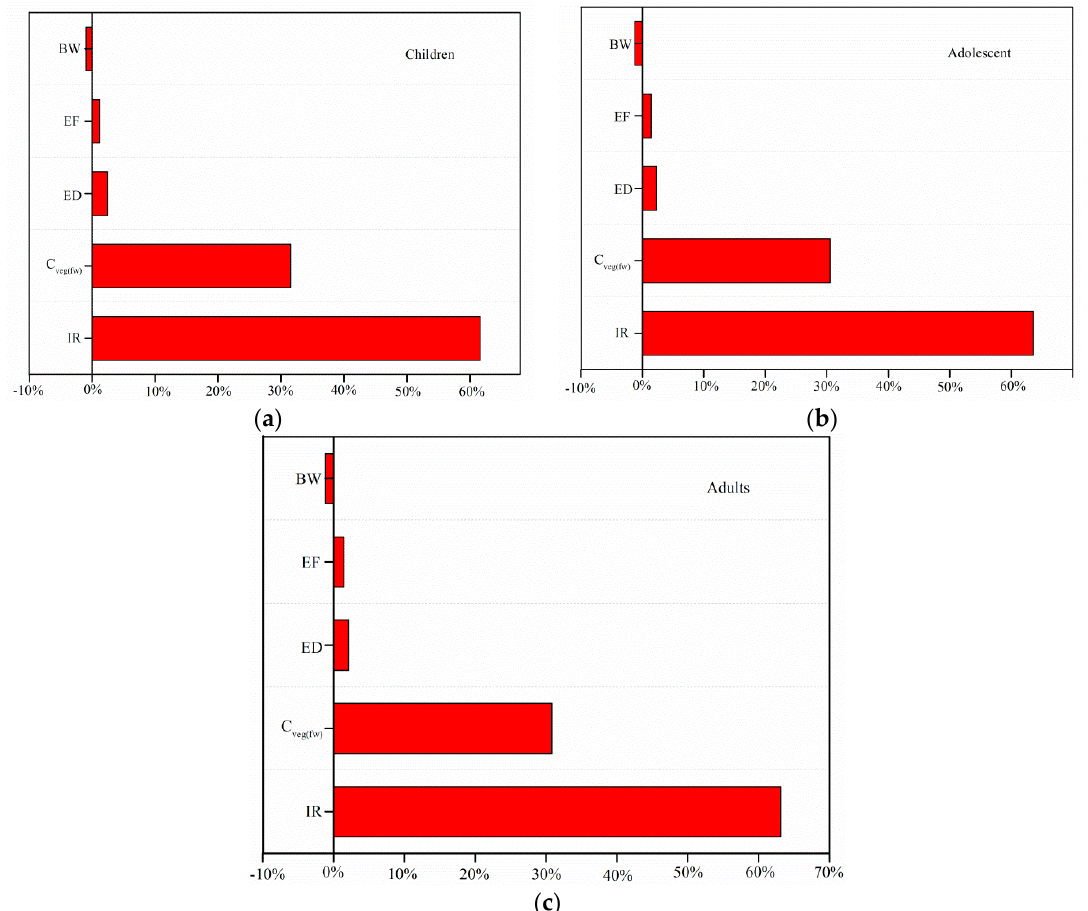
Figure 5. Sensitivity analysis of non-carcinogenic risks for ( a ) children, ( b ) adolescents, and ( c ) adults.